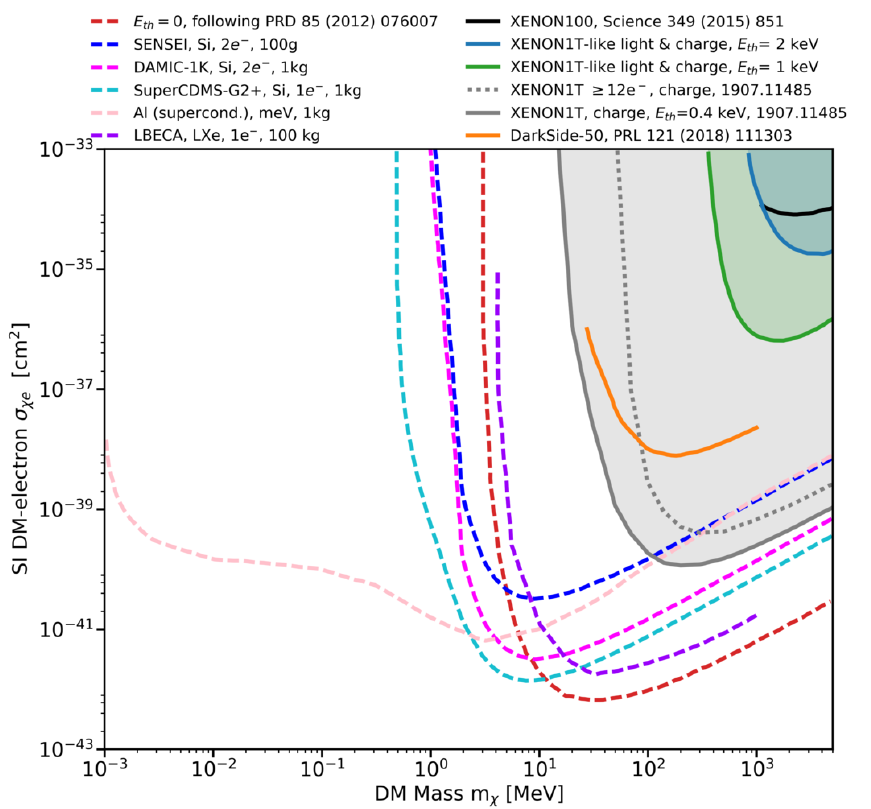
Figure 9 . Experimental upper limits and estimated sensitivities for the DM-electron scattering cross section (cid:22) (cid:27) (cid:31) e in LXe, LAr and other detectors. Shown are the previously estimated sensitivity for a 60 kg-year exposure assuming only irreducible neutrino backgrounds and no detection thresholds (red dotted) [53{56] together with our sensitivity estimates for an assumed electron energy detection threshold of 2 keV (blue) and 1 keV (green), respectively, for a 1 ton-year exposure of XENON1T with realistic assumptions at 95 % con(cid:12)dence level (C.L.) [28]. Also shown are published limits from XENON100 (black) [88] and a charge-only analysis of XENON1T [91] (gray full line), both at 90 % C.L. The gray dotted line is a more conservative version of the latter limit considering that electron recoils below 186 eV (12 produced electrons) are undetectable, as the LXe charge yield Q y has never been measured below these energies [91]. For comparison, we also show the ionisation- only limit in Argon from DarkSide-50 (orange full line) [92] and sensitivity projections (dashed lines) for SENSEI (blue), DAMIC-1K (magenta), Al (supercond.) (pink), SuperCDMS (cyan) [93] and LBECA (purple)